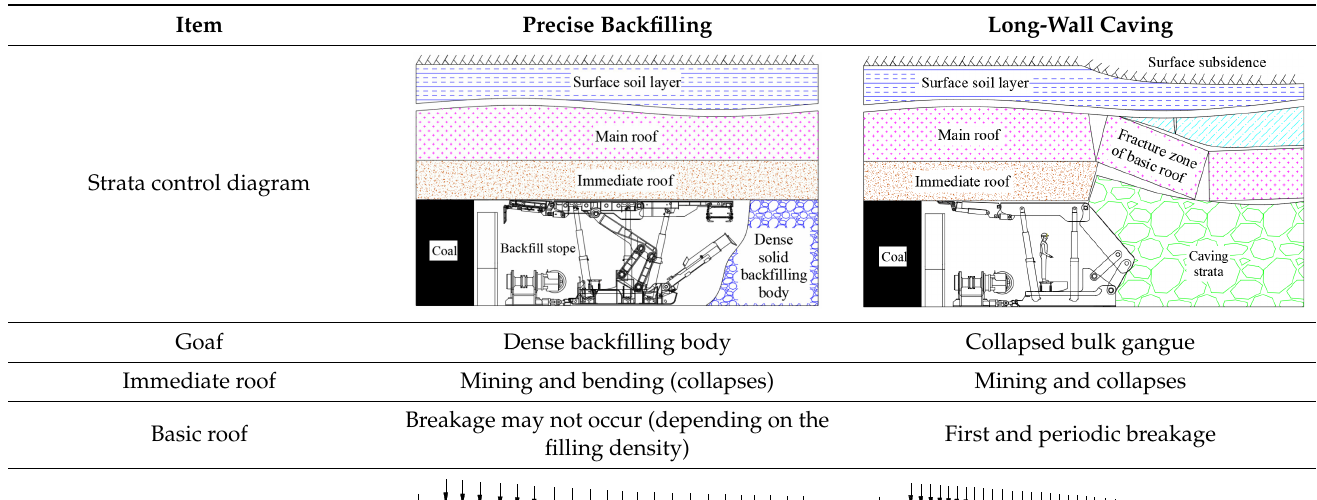
Table 1. Comparison of rock-beam structure characteristics.